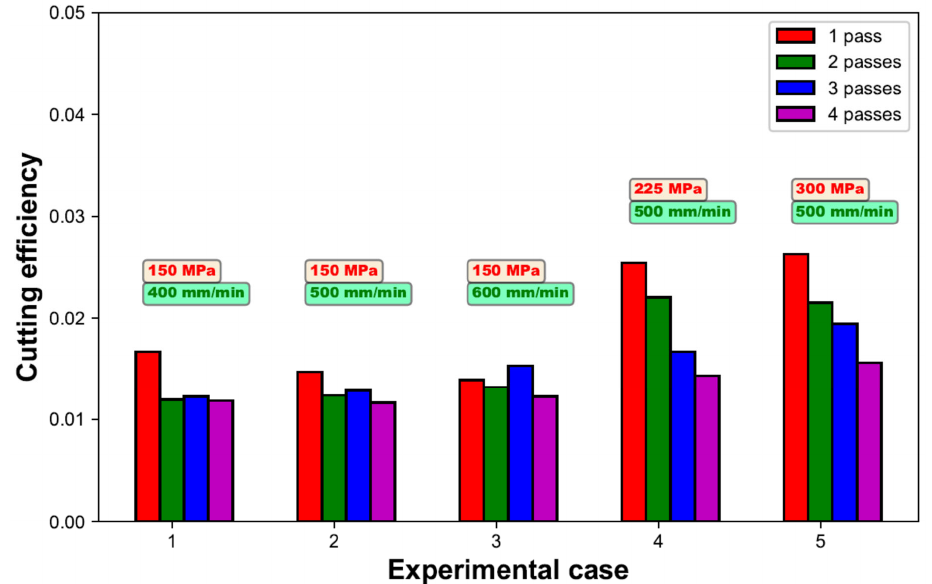
Figure 10. Variation of the cutting efficiency when increasing the number of passes and with dif ‐ ferent process conditions.